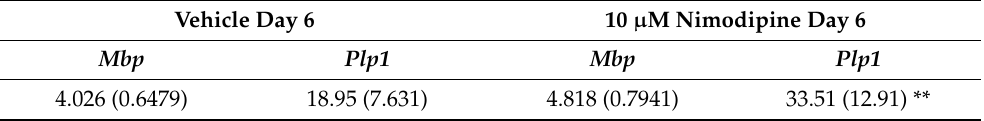
Table 2. Mean (SE) fold change in Mbp and Plp1 expression relative to Day 0 (baseline) in OLN-93 cells in response to nimodipine on Day